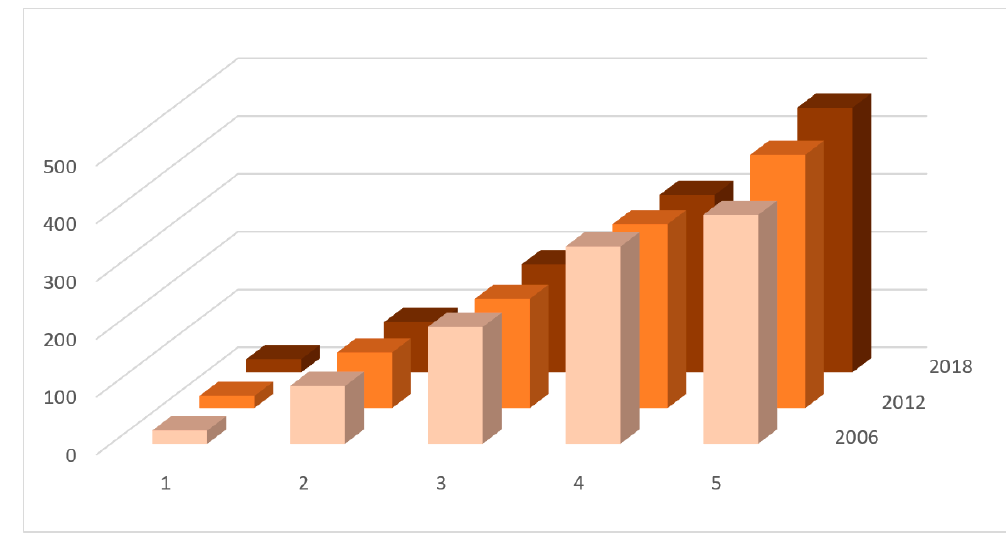
Figure 6. Number of EUM in classes.